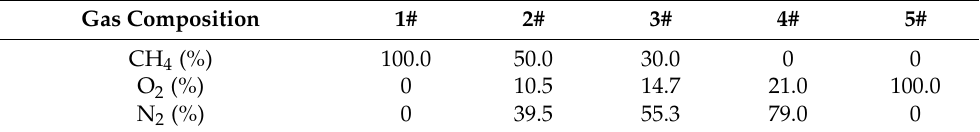
Table 1. Different oxygen concentration ratio.